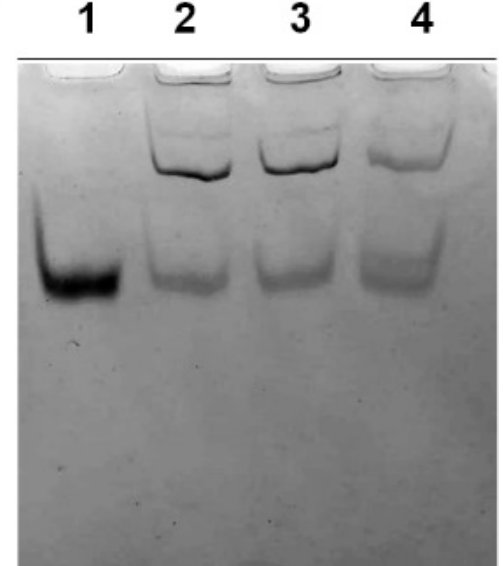
Figure 2. Acetic Acid Urea-Polyacrylamide Gel Electrophoresis (AU-PAGE) analysis of the cytosolic fraction from Hg-treated human RBC. Intact RBC were exposed in vitro for 4 h to different concentrations of HgCl 2 and the cytosolic fraction analysed by AU-PAGE. Samples from untreated RBC (lane 1) and cells exposed to 1, 10 and 60 µM HgCl 2 (lanes 2–4, respectively).